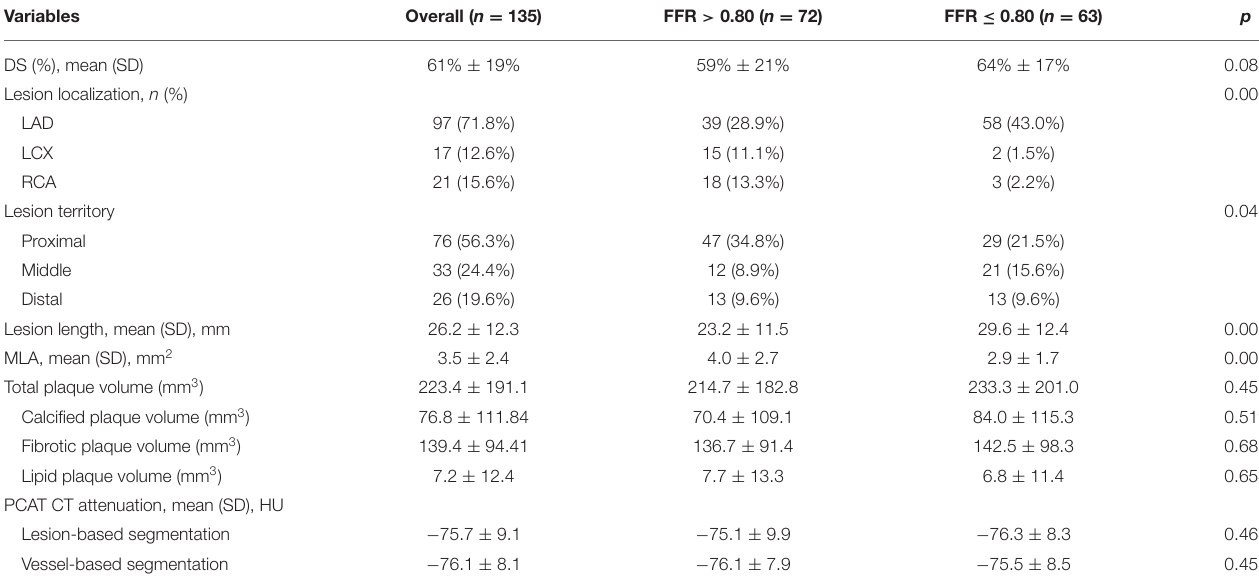
TABLE 2 | Lesion characteristics in coronary computed tomography angiography. Variables